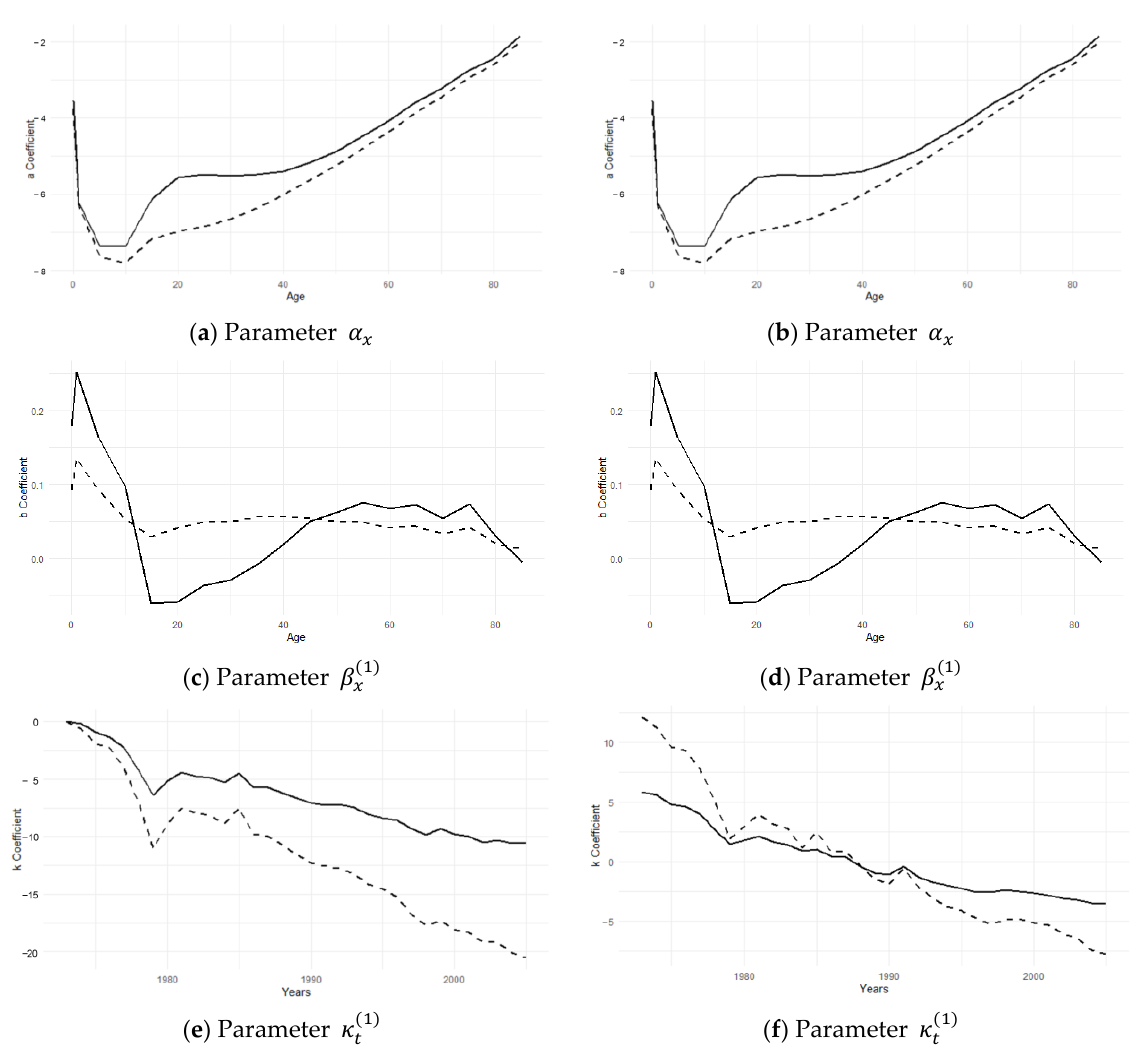
Figure 2. Parameter plot for LC1 and LC2 models for both male (solid line) and female (dashed line). Note that model LC1 is denoted by ( a , c , e ), while model LC2 is denoted by ( b , d , f